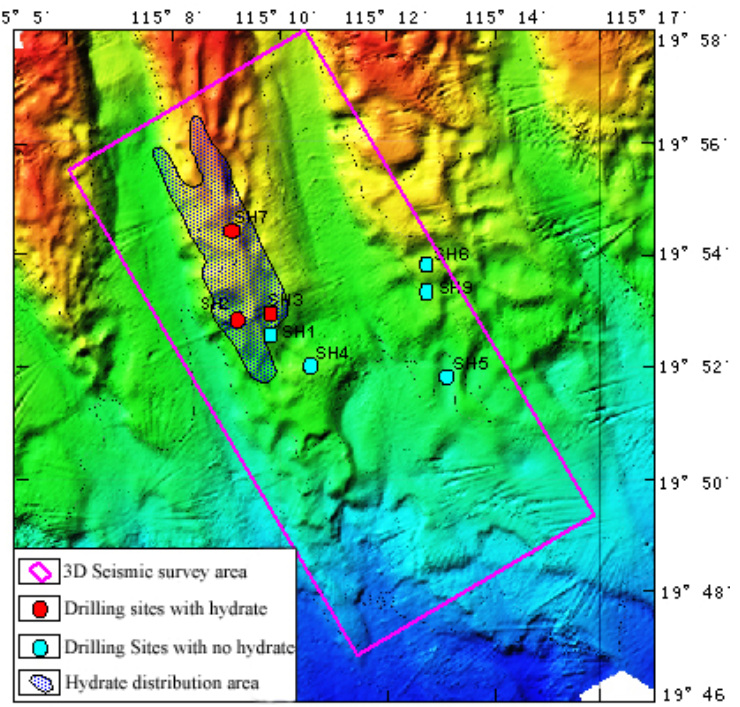
Figure 1. Bathymetric map of gas hydrate drilling area with sites drilled in the Shehu Area, northern continental slope of South China Sea